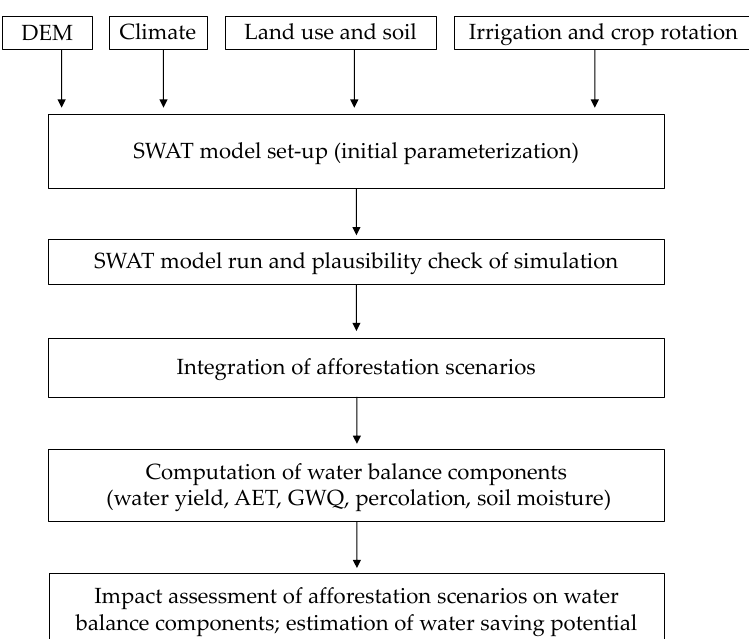
Figure 2. Methodology flowchart diagram.